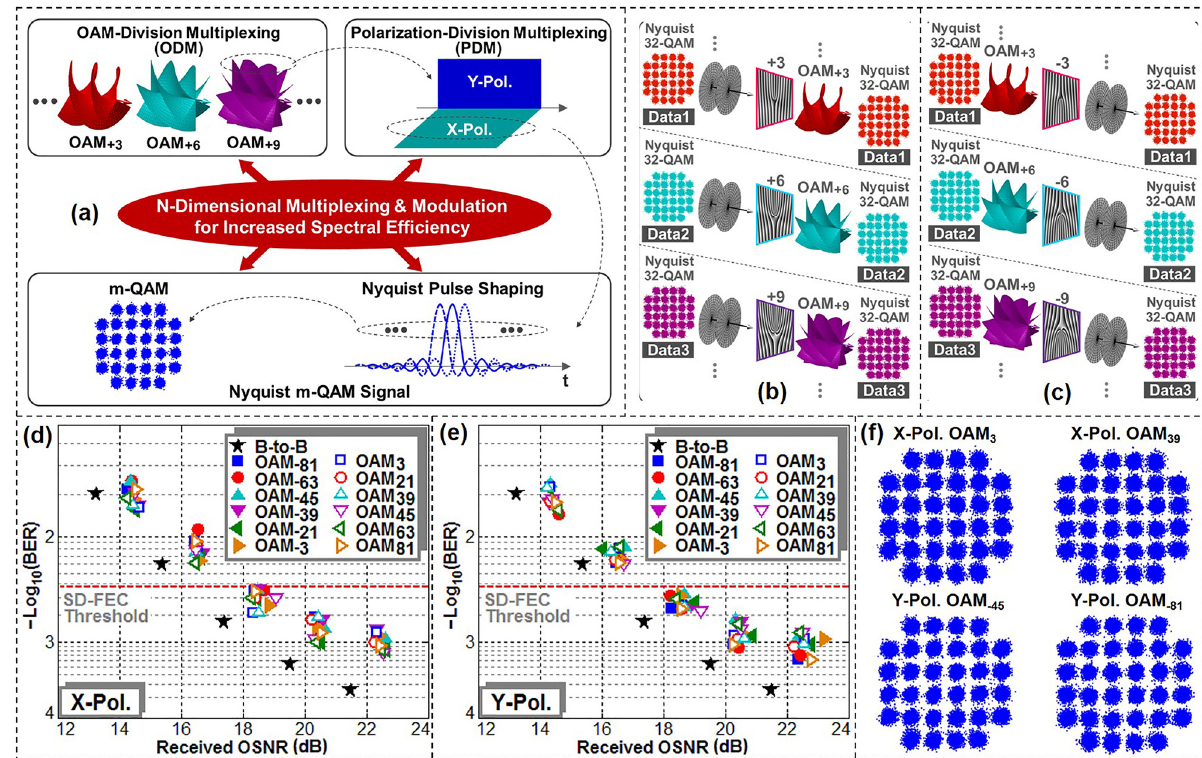
Figure 10: N -dimensional OAM multiplexing communications with an ultra-high spectral ef fi ciency of 435 bit/s/Hz. (a) Concept of N -dimensional multiplexing and modulation. (b) Conversion from data-carrying Gaussian beams (planar phase front) to data-carrying OAM beams (helical phase front). (c) Back-conversion from data-carrying OAM beams (helical phase front) to data-carrying Gaussian-likebeams(planarphasefront).MeasuredBERversusOSNRfortypical(d)X-and(e)Y-polarizedOAM − 81 ,OAM − 63 ,OAM − 45 ,OAM − 39 , OAM − 21 , OAM − 3 , OAM 3 , OAM 21 , OAM 39 , OAM 45 , OAM 63 and OAM 81 channels. (f) Measured constellations for X-polarized (X-Pol.) OAM 3 , X-Pol. OAM 39 , Y-polarized (Y-Pol.) OAM − 45 , Y-Pol. OAM − 81 [86]. Reprint permission obtained from shown in Figure 11a. Figure 11b and c plotted measured op- tical spectra (C + L bands) before and after the OAM trans- mission link, respectively. The BER curves for typical single wavelength in the C-band and L-band were plotted in Figure 11d and e, respectively. The observed OSNR penalties were less than 2 dB at a BER of 1.5e-2 (HD-FEC limit). Insets of Figure 11d and e depicted measured constellations.